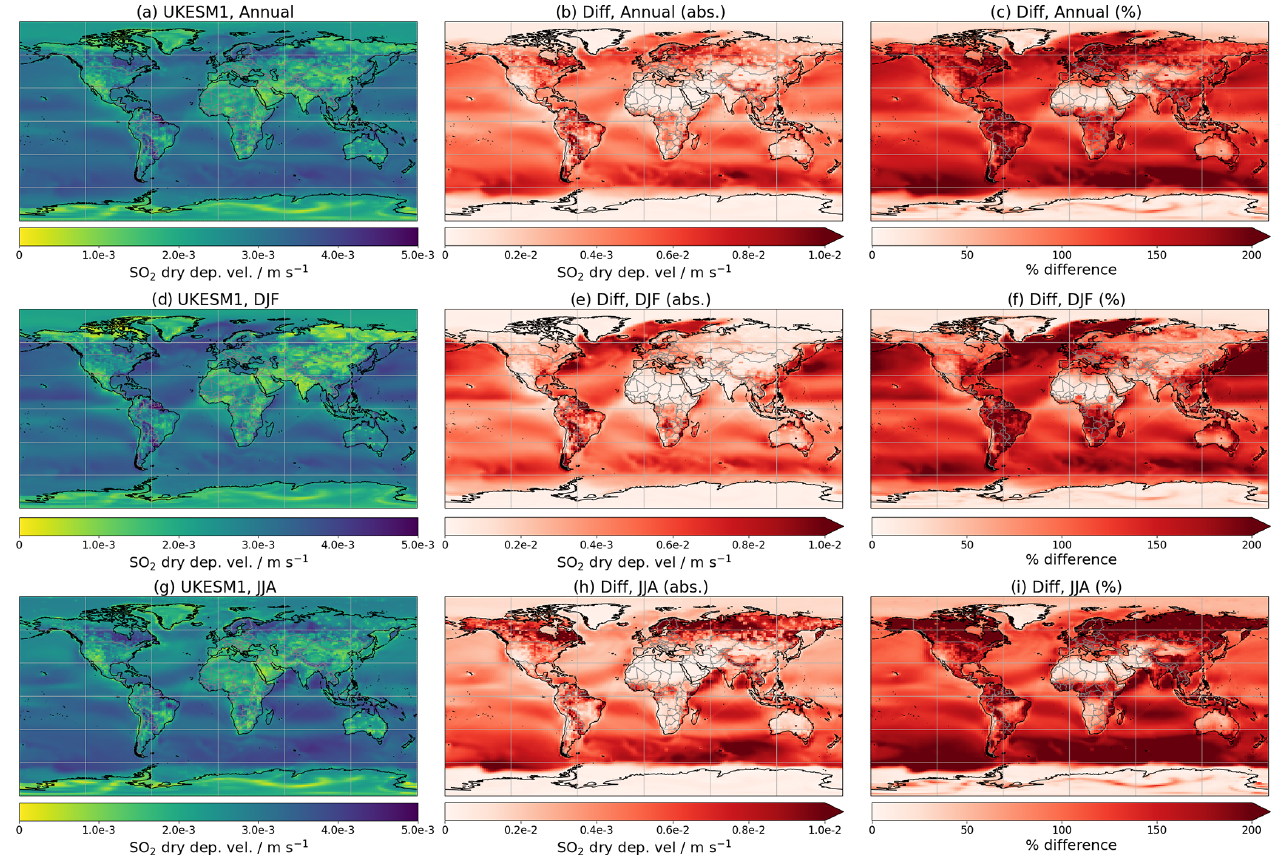
Figure 10. SO 2 dry deposition velocity for UKESM1 (a, d, g) , absolute difference in SO 2 dry deposition velocity for UKESM1-SO2 – UKESM1 (b, e, h) , and percentage difference in SO 2 dry deposition velocity for UKESM1-SO2 – UKESM1 (c, f, i) . Annual means are shown in (a) – (c) , the DJF mean is shown in (d) – (f) , and the JJA mean is shown in (g) – (i) . Each plot shows mean data for the period 1987– 2014. Deposition velocity is calculated from the simulated surface SO 2 and dry deposition flux values and represents the “bulk” deposition velocity for each model grid